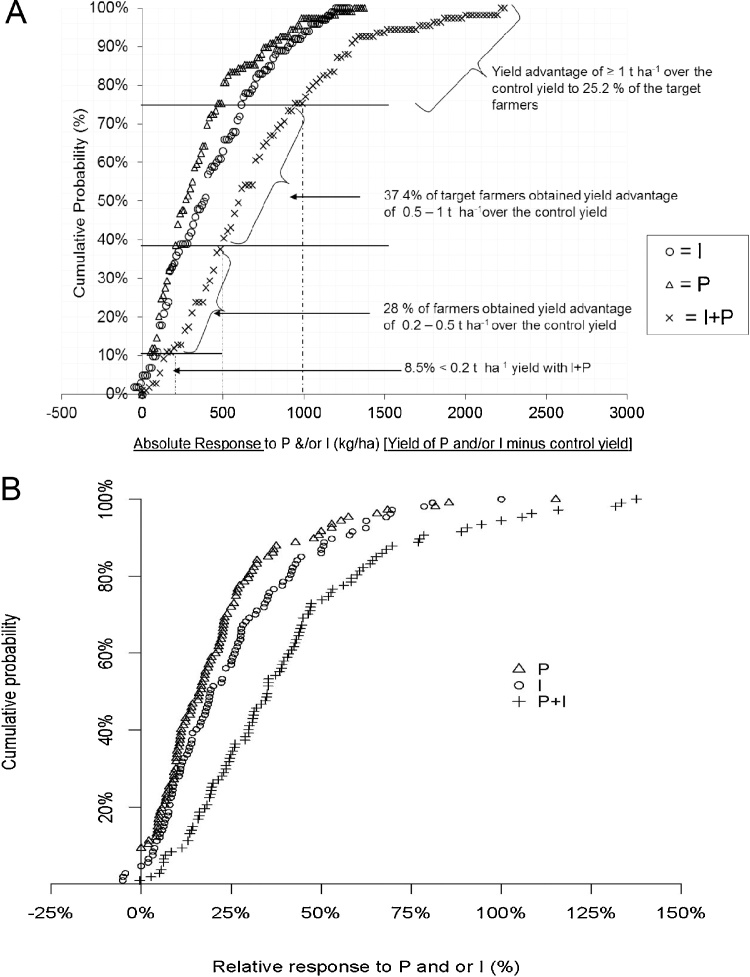
A Cumulative probability of absolute response (kg ha−1) in chickpea yield to P and/or I compared with the control treatment. B Cumulative probability of relative response (kg ha−1) in chickpea yield to P and/or I compared with the control treatme.